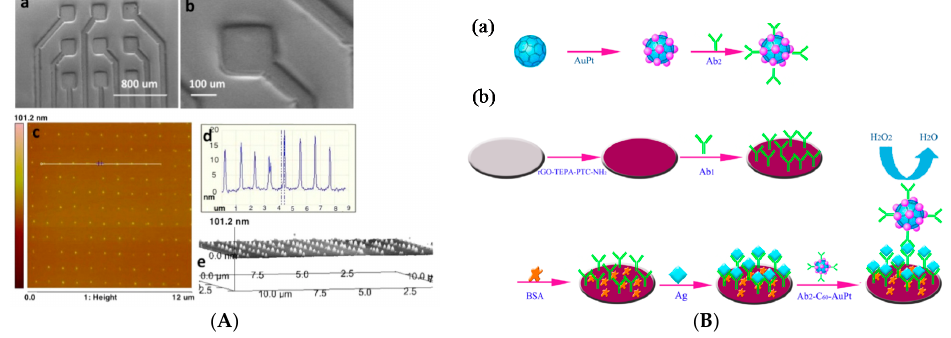
Figure 8. ( A ) Biosensor chip for CRP, cTnT and myoglobin; ( a ) SEM image of an array of 9 electrodes, and ( b ) of an individual electrode; ( c ) AFM image of an array carbon nanofibers (bright dots); ( d ) AFM profile of the carbon nanofibers height; ( e ) 3D AFM micrograph after antibody immobilization. Reprinted from [47], Copyright 2016, with permission from Elsevier; ( B ) ( a ) Ab 2 –C 60 –AuPtNPs